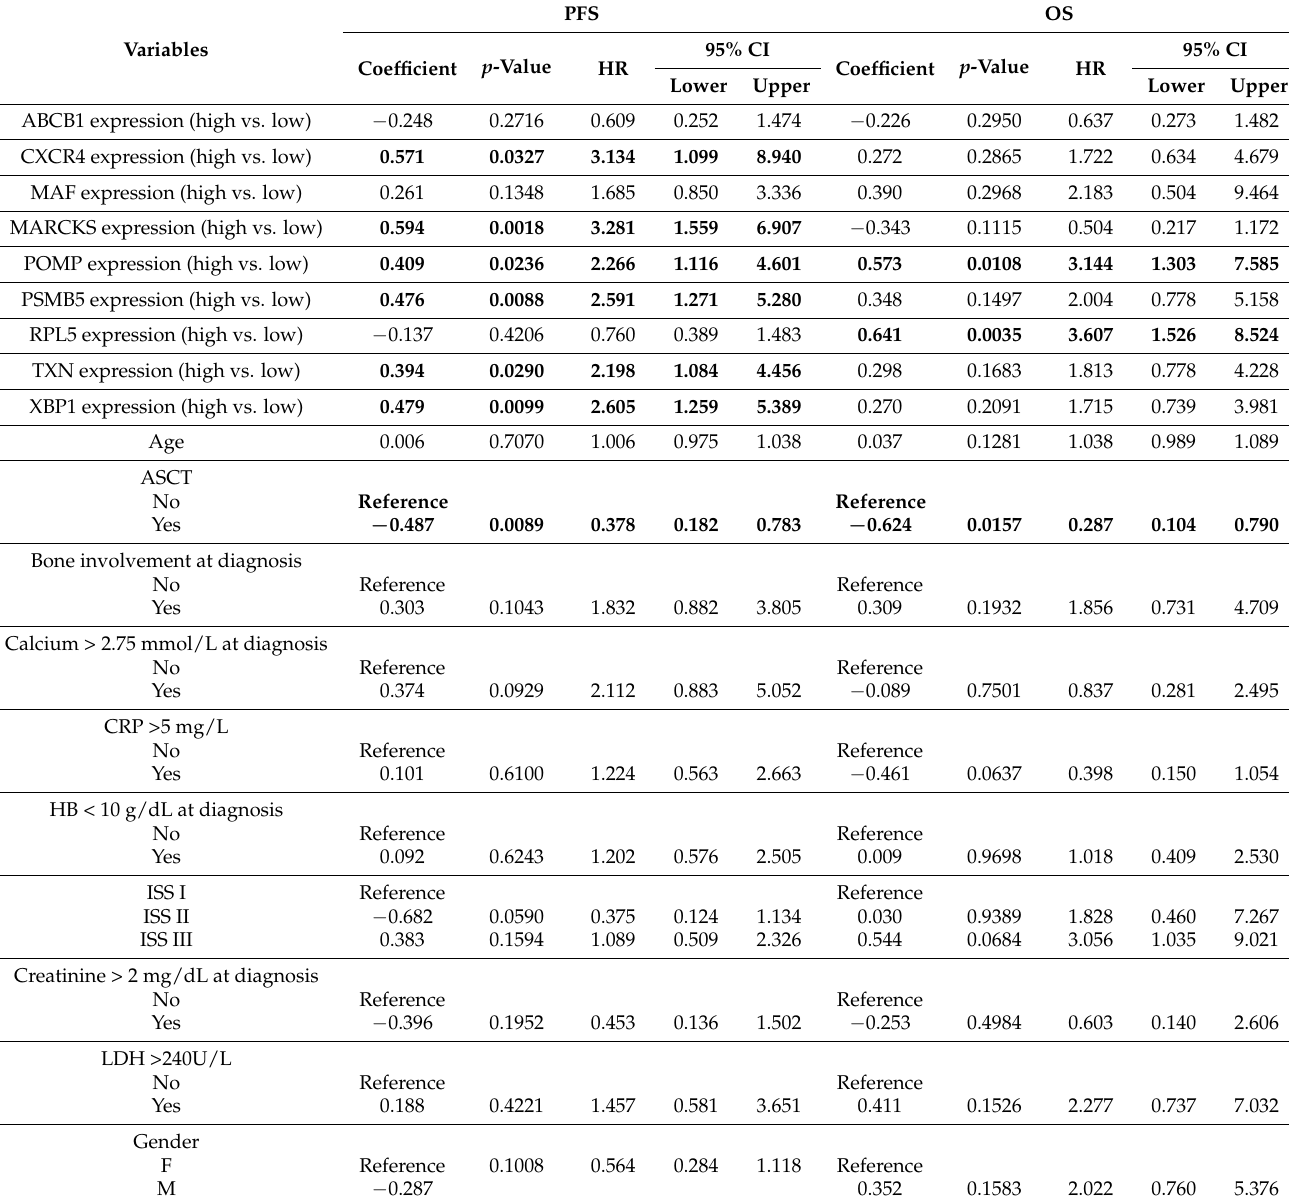
Table 4. Univariate Cox regression analyses for progression-free survival and overall